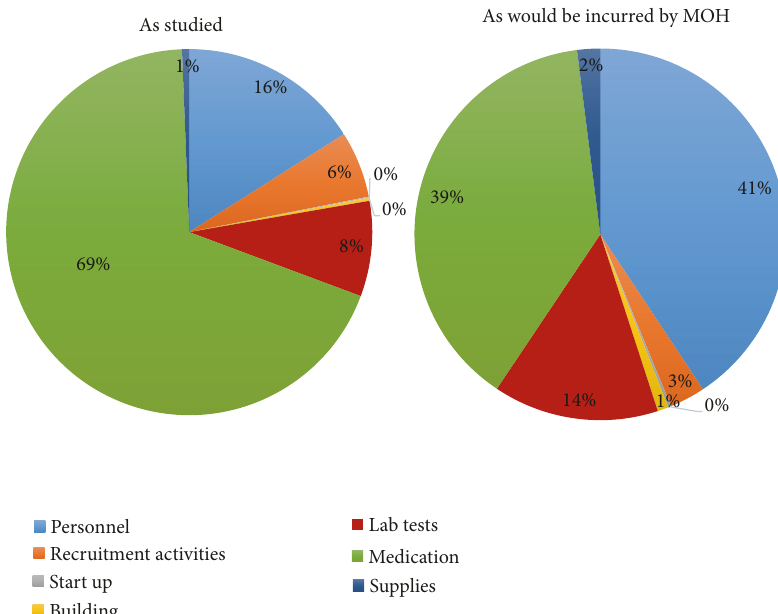
Figure 2: Allocation of incremental cost of PrEP delivery in a year, by resource type. The personnel cost is the salary for personnel providing